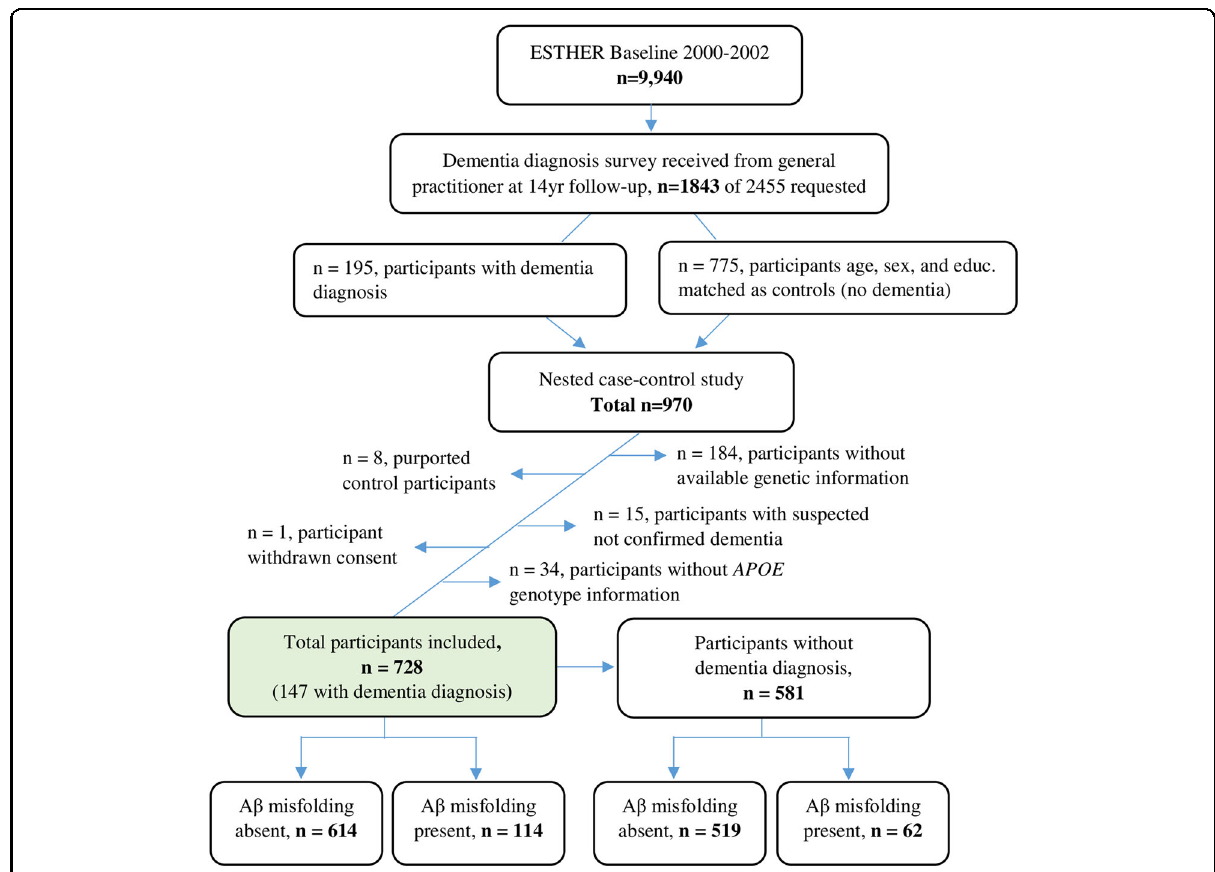
Fig. 1 Flow chart of ESTHER study participants included in